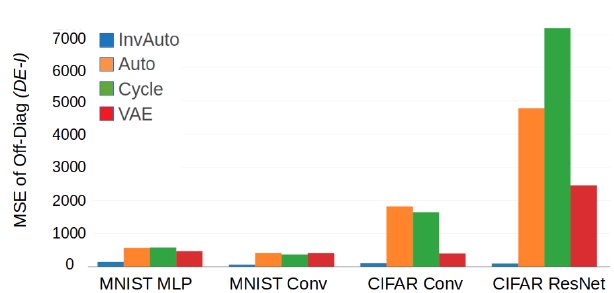
Figure A1. Comparison of the MSE of the diagonal of DE − I for InvAuto, Auto, Cycle, and VAE on MLP, convolutional (Conv), and ResNet architectures and MNIST and CIFAR datasets.